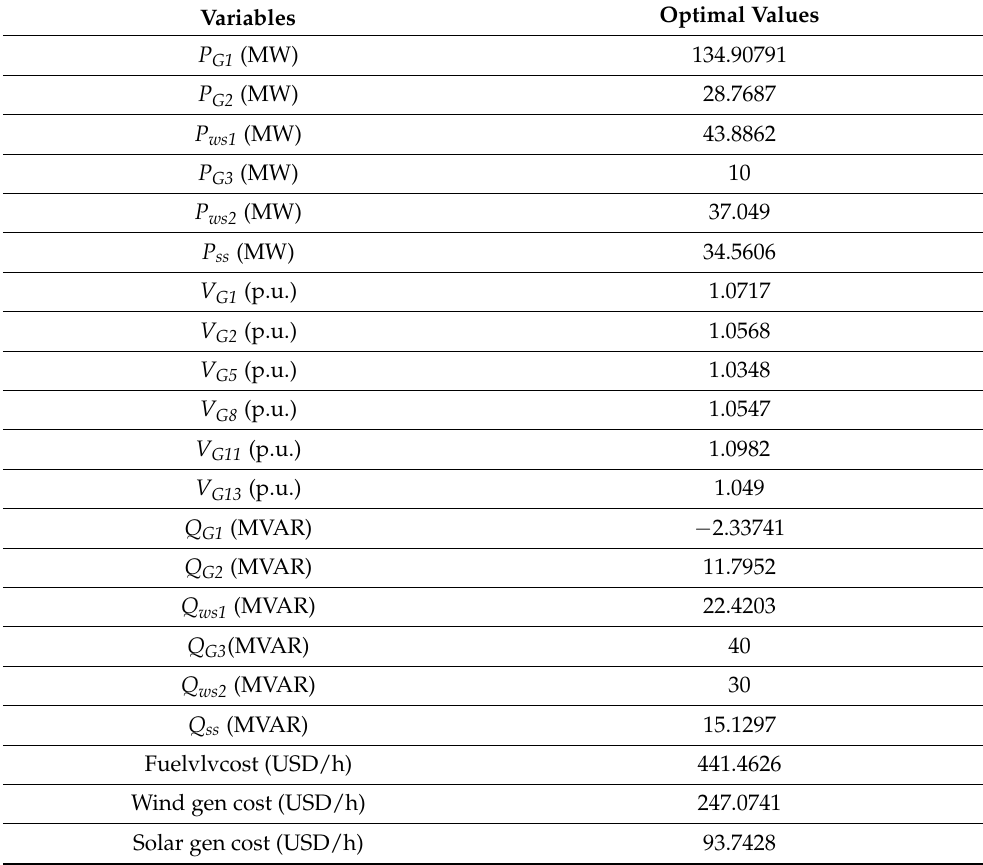
Table 10. The optimal values by HFAJAYA for Case